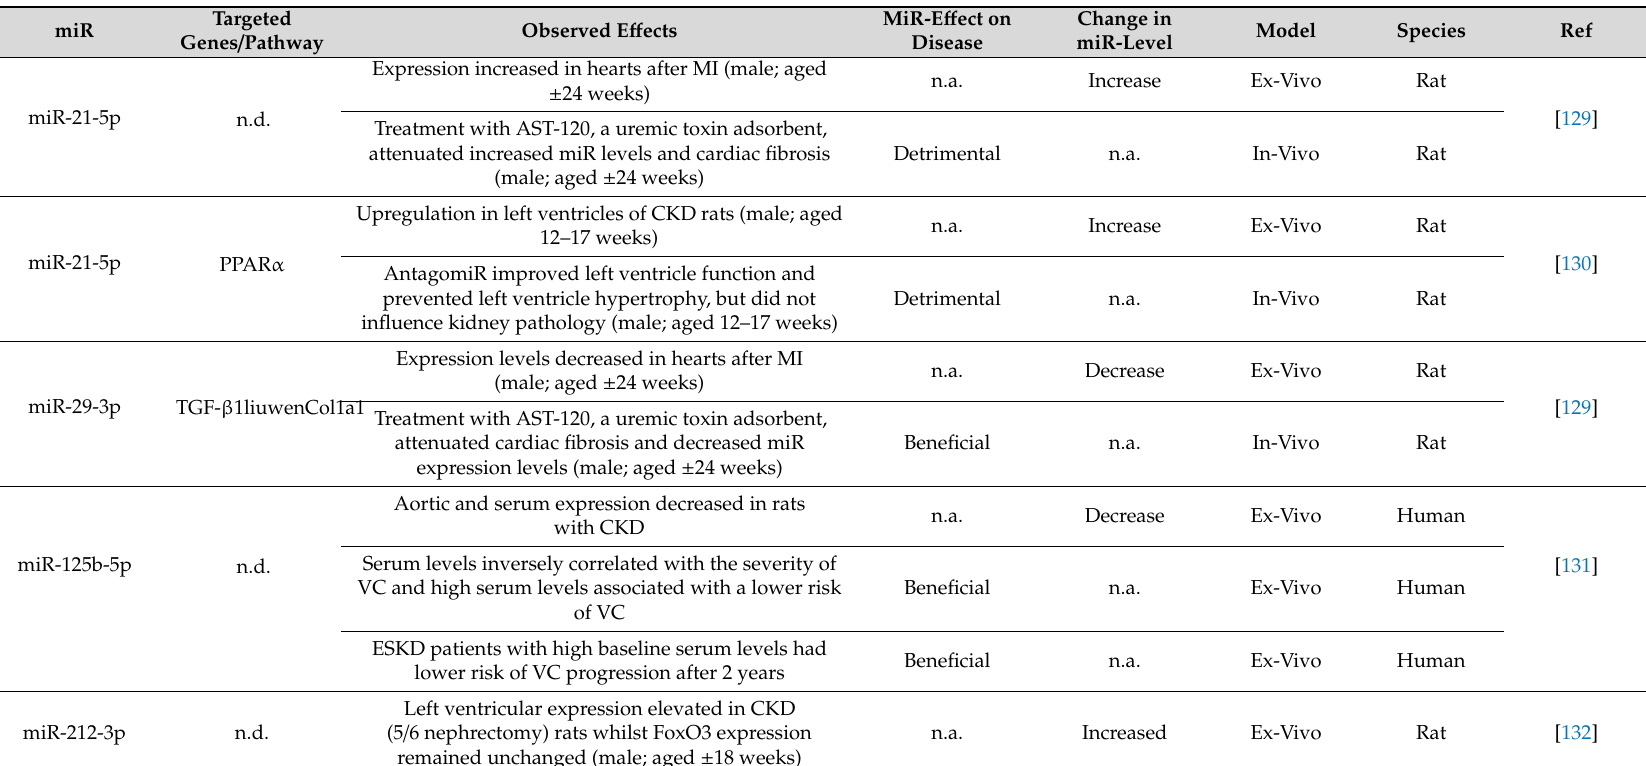
Table 6. Overview of miRs that are involved in CKD-related CVD (only ex-vivo / in-vivo evidence).